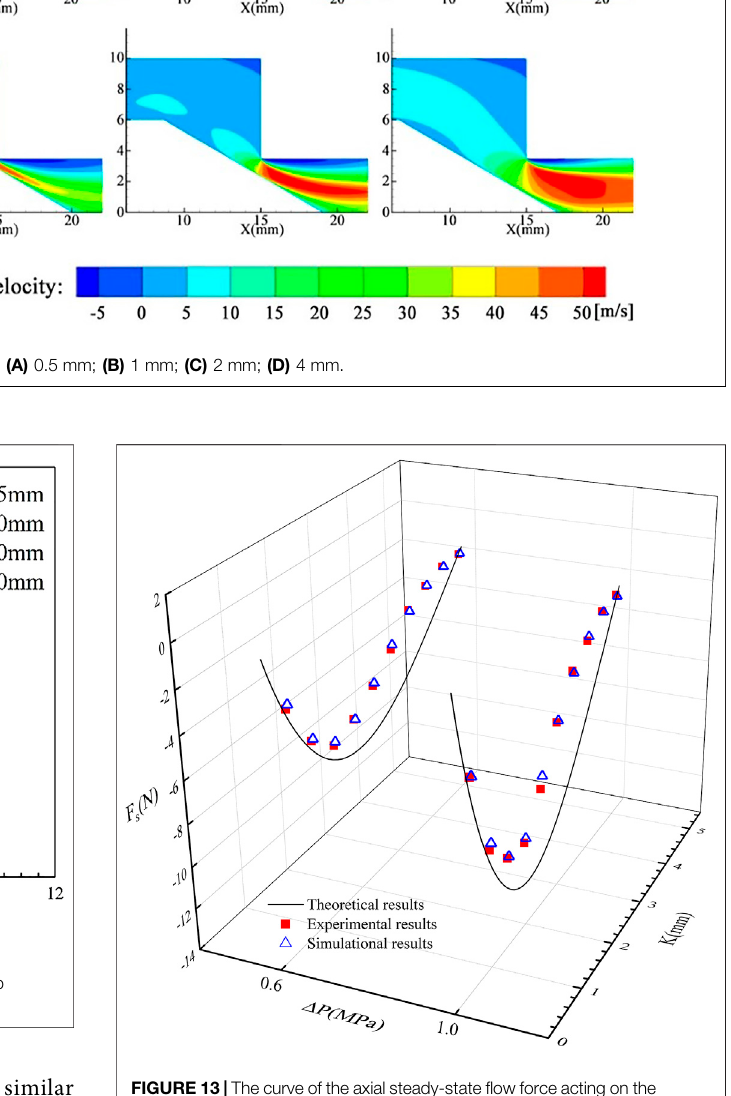
FIGURE 13 | The curve of the axial steady-state fl ow force acting on the valve core with different